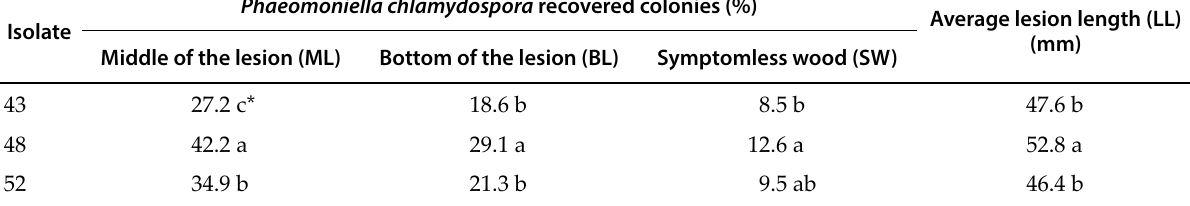
Table 2. Mean proportions (%) of Phaeomoniella chlamydospora recovered from the middle of lesion, bottom of the lesion or from symptomless wood, and mean lesion lengths, recorded after inoculations of four grapevine cultivars in three trial